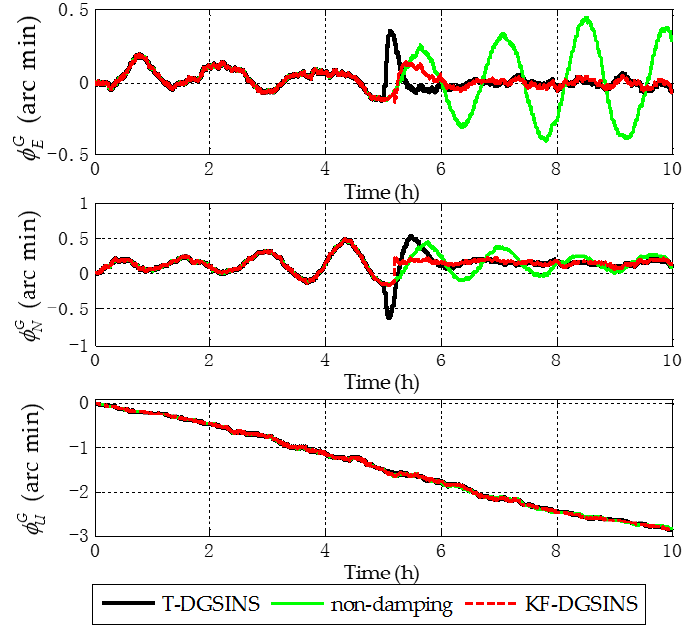
Figure 13. Grid attitude angle errors of the semi-physical simulation results.